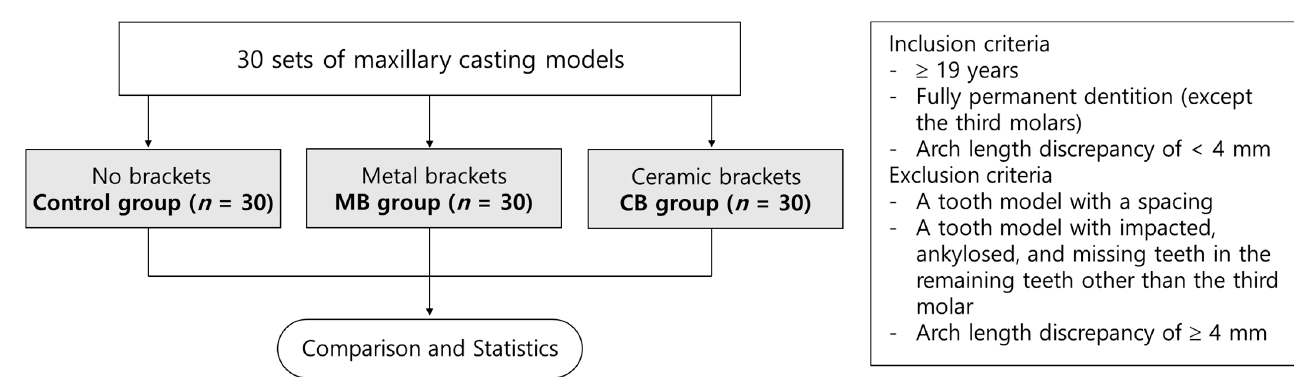
Figure 1. Flow chart of study protocol.